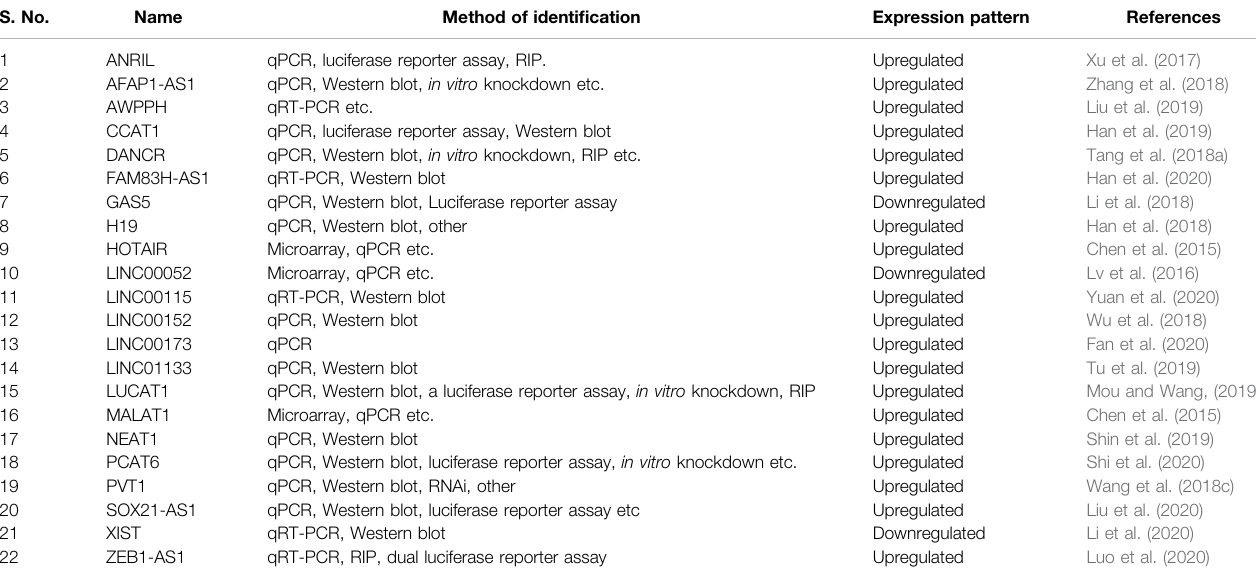
TABLE 2 | LncRNAs impacting TNBC via the Wnt/ β -Catenin axis mined from the lnc2 Cancer database. S.